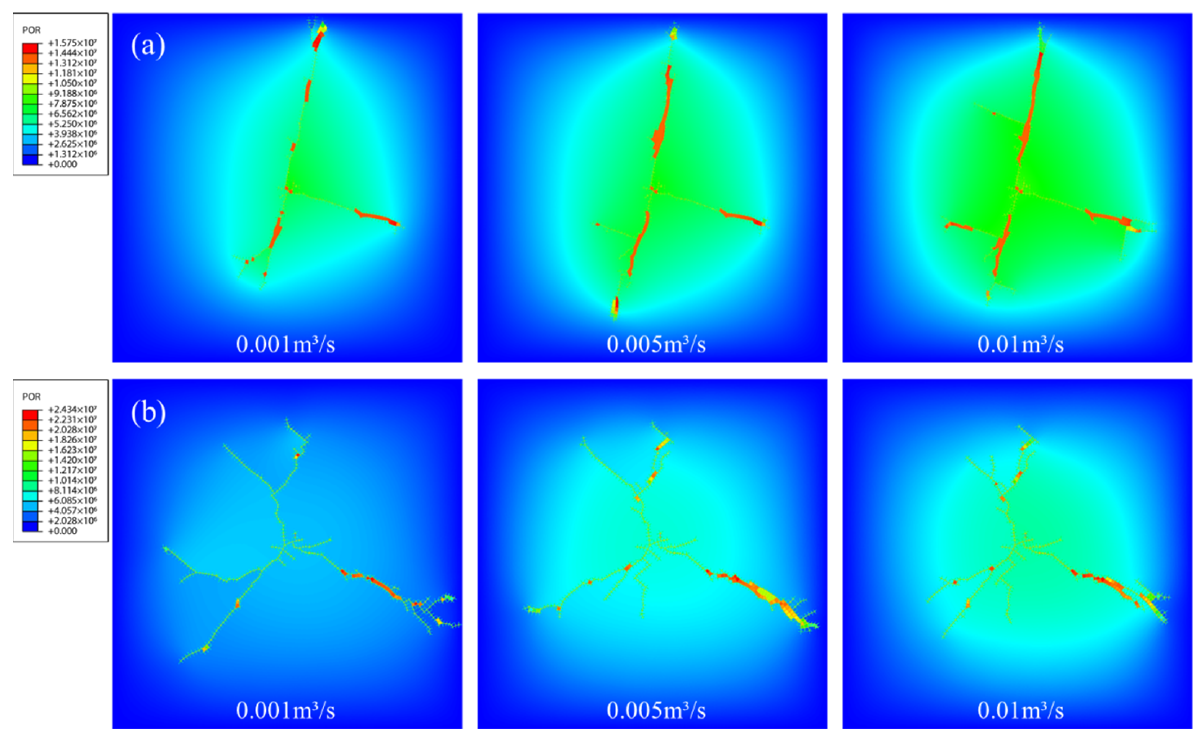
Figure 11. Results of fracturing group A ( a ) and group B ( b ) under different inject rates. First line in subfigures represent the results of natural fracture group A and second line is group B